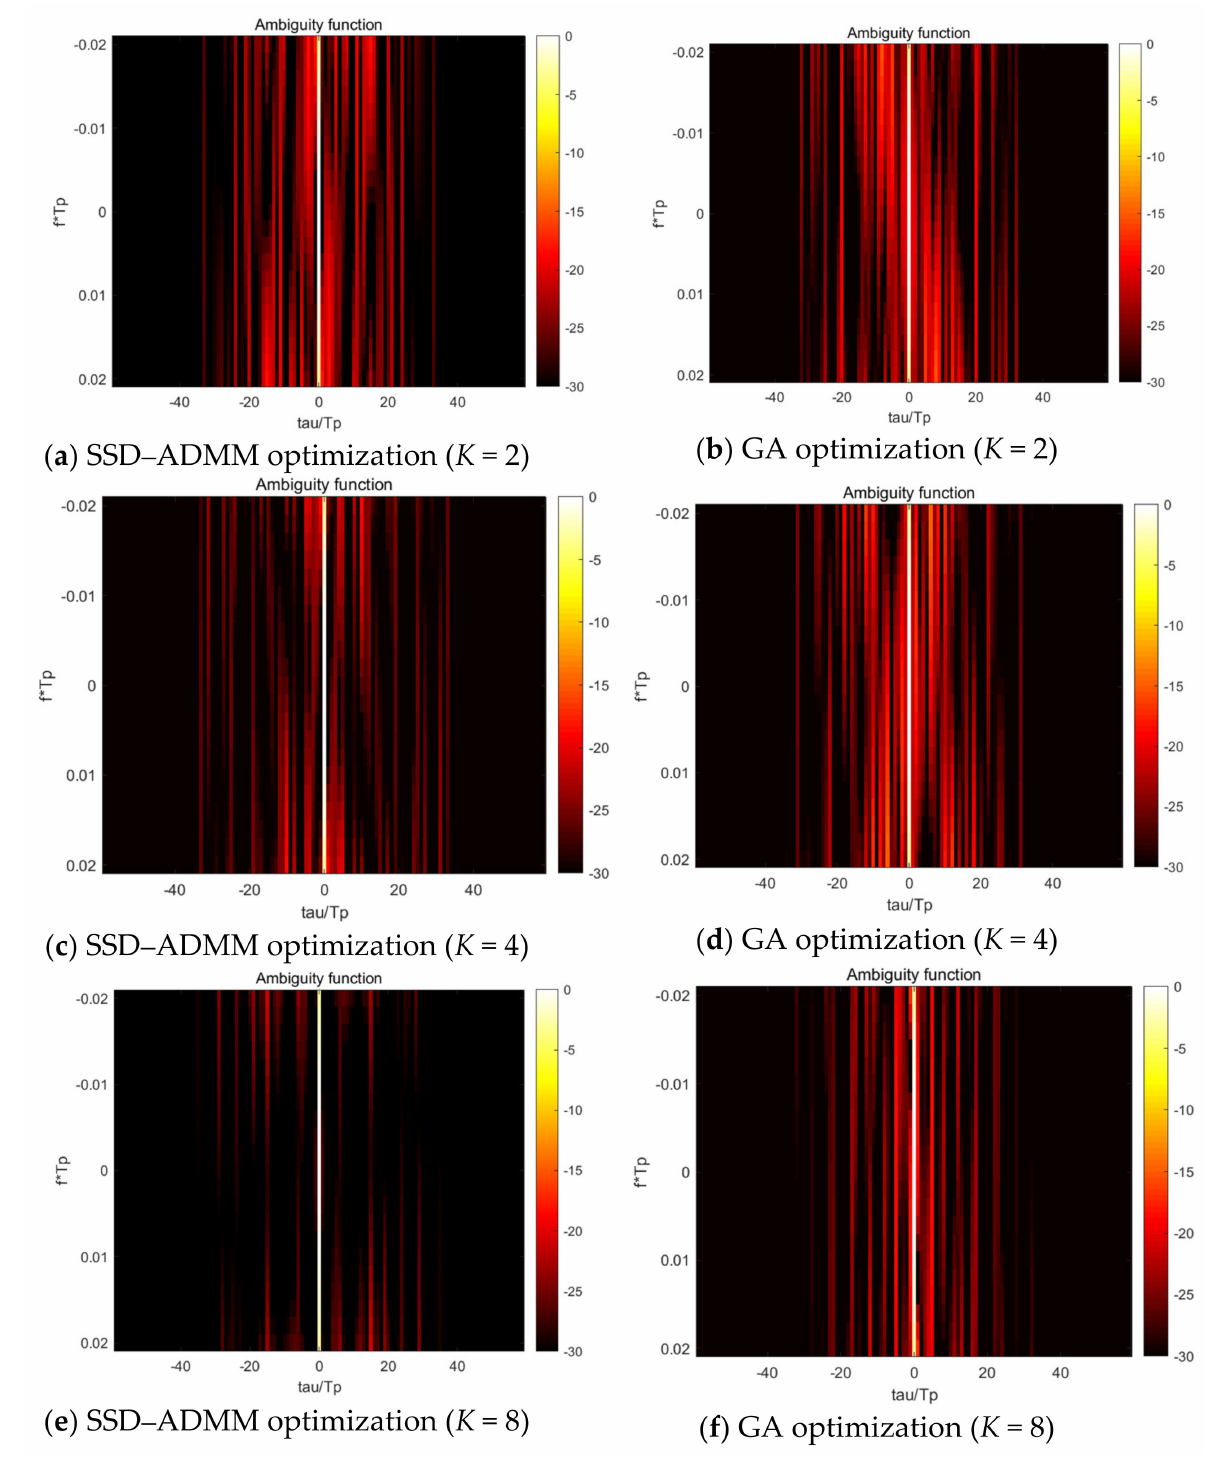
Figure 2. Ambiguity function after optimization. Table 5. AINSL after